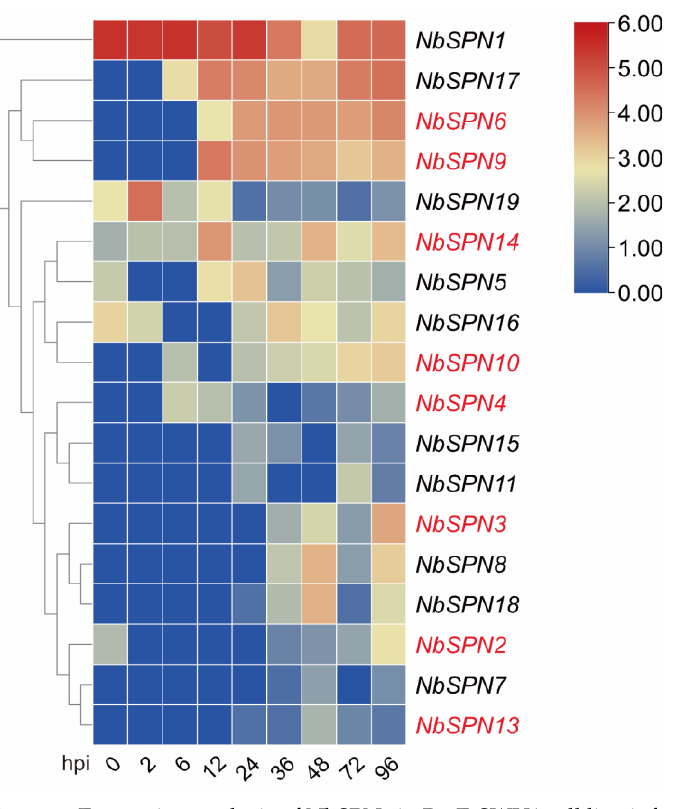
Figure 8. Expression analysis of NbSPNs in BmE-SWU1 cell line infected by N. bombycis . Heatmap generated by TBtools showing a cluster map of the NbSPN genes in infected BmE-SWU1 cells. The predicted genes that could encode signal peptides are marked in red. The color gradient (red/white/blue) indicates the gene expression level (high to low).